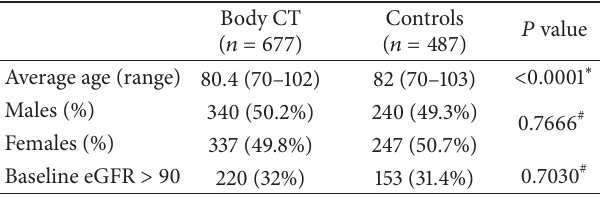
Table 1: Demographic data and baseline eGFR (mL/min/1.73m 2 ).